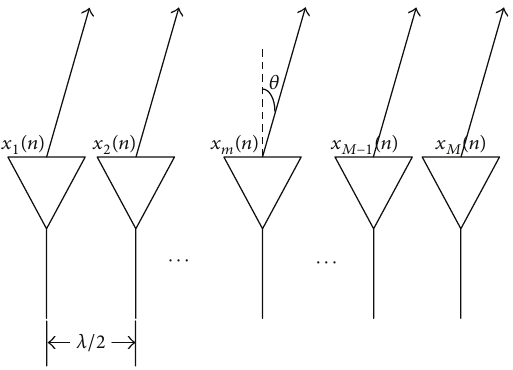
Figure 1: MIMO radar system transmitted array